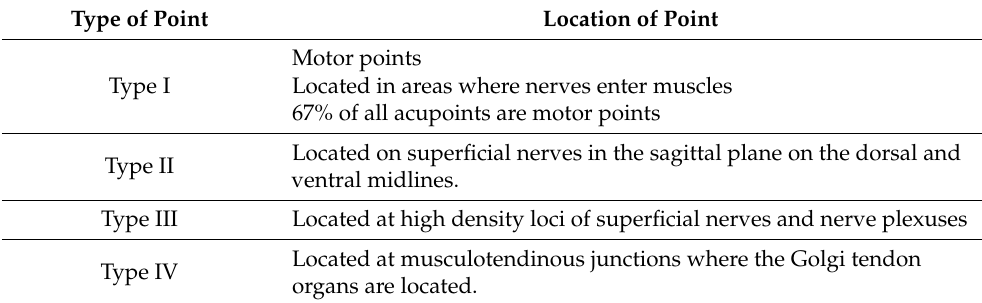
Table 1. Types of Acupuncture points (Data from Reference